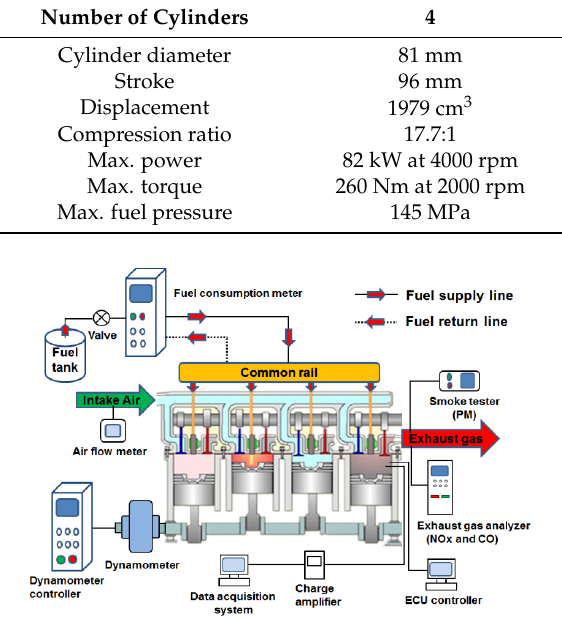
Table 3. Specifications of the test engine.